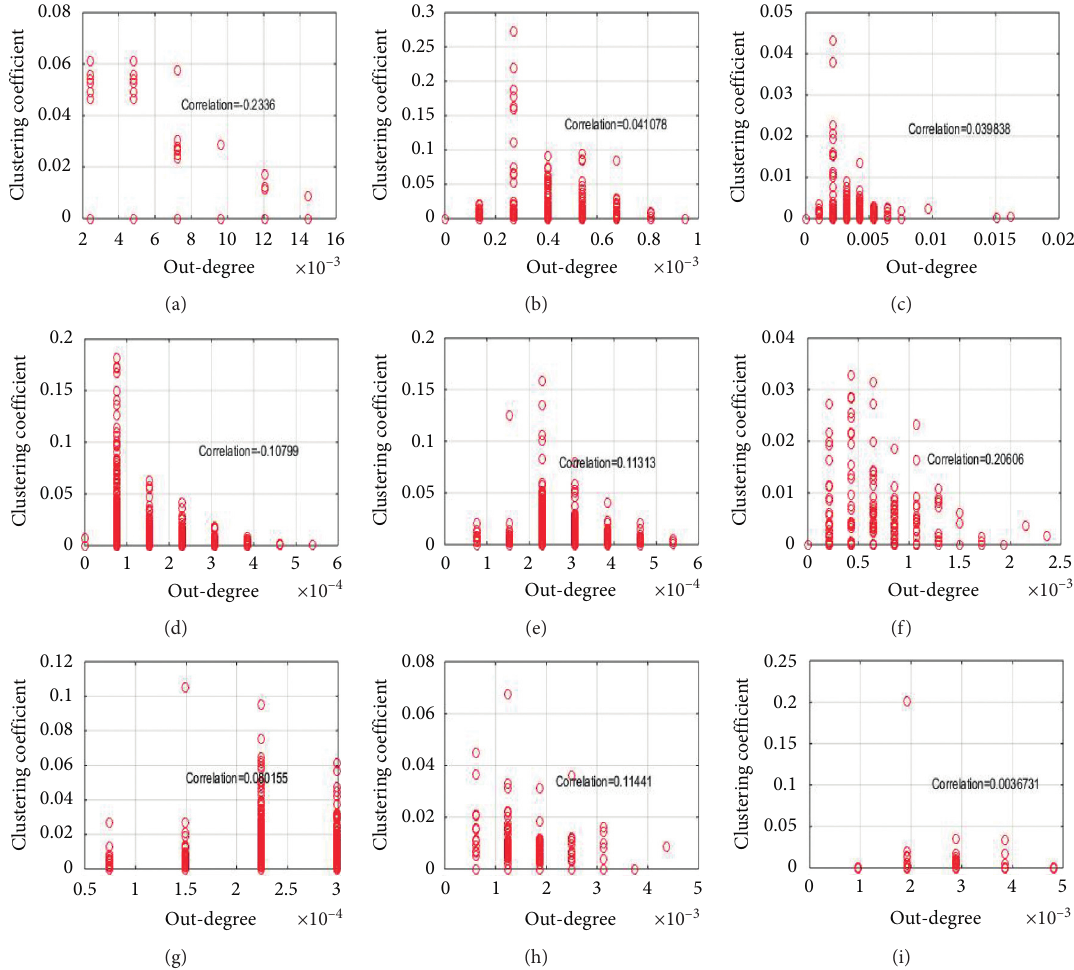
Figure 11: The correlation between normalized out-degree and clustering coefficient: (a) Anaheim; (b) Austin; (c) Barcelona; (d) Berlin; (e) Chicago; (f) Hessen; (g) Philadelphia; (h) Terrassa; (i)